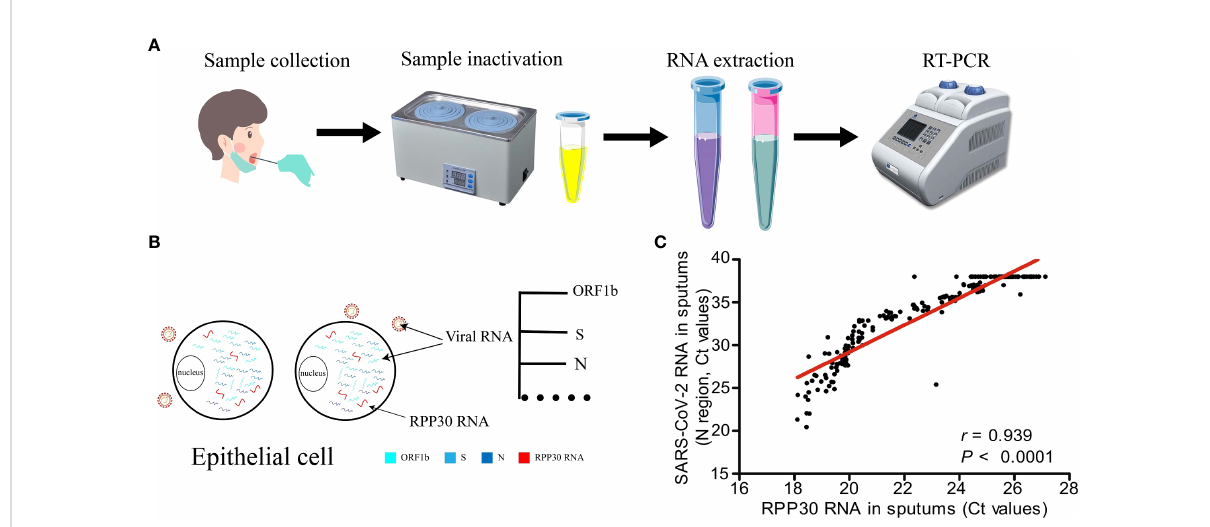
FIGURE 5 Ribonuclease P protein subunit p30 ( RPP30 ) is used as an internal reference gene in the detection of SARS-CoV-2. (A) Sample collection and reverse transcription-polymerase chain reaction (RT-PCR), (B) Viral RNA coexists with RPP30 in epithelial cells, (C) Detection results of RPP30 and SARS-COV-2 are signi fi cantly positively correlated